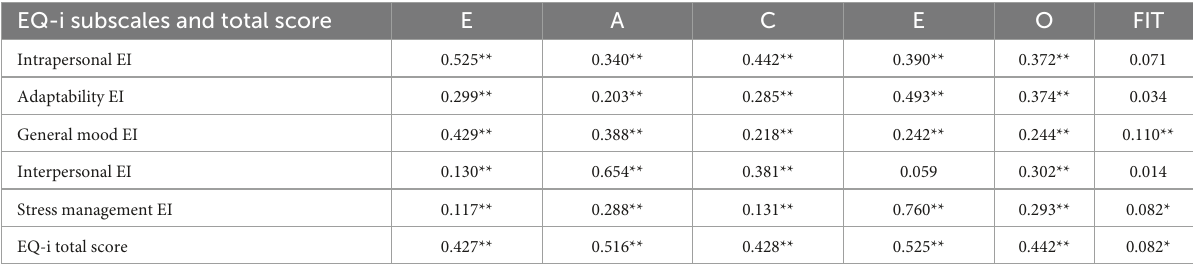
TABLE 2 Correlations among the five dimensions and the global score of the EQ-i, the personality traits, and the FIT. EQ-i subscales and total score